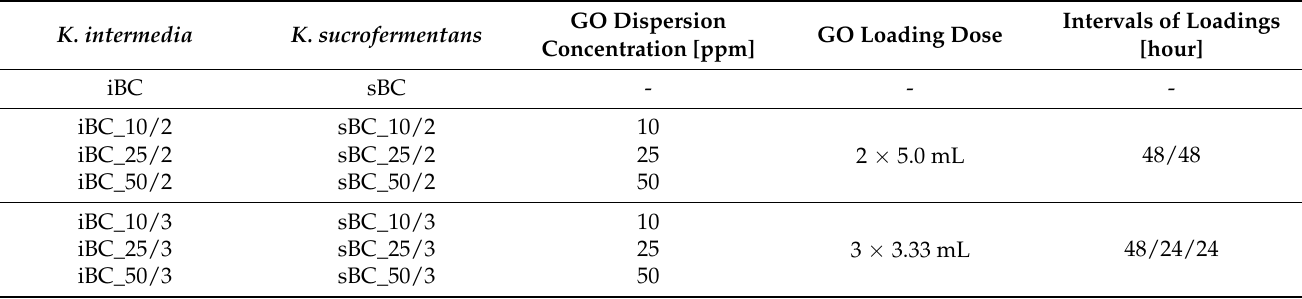
Table 1. Designation of the obtained BC and GO/BC nanocomposites.